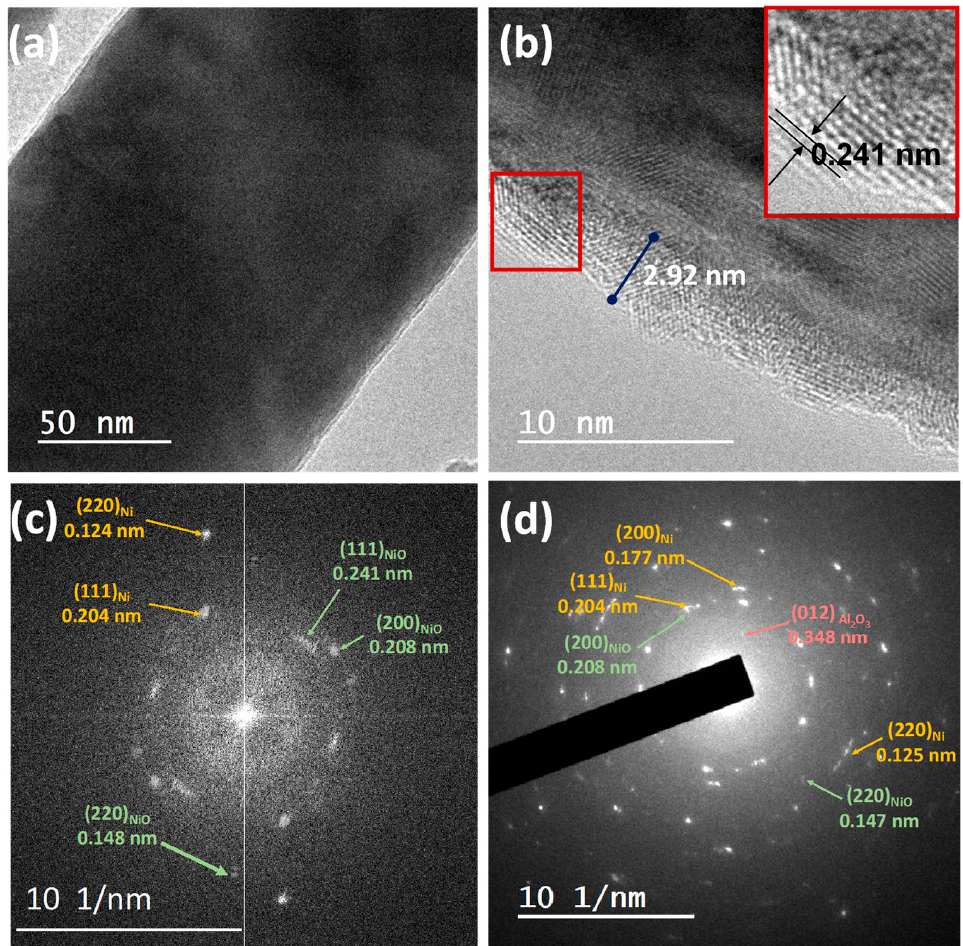
Figure 2. TEM and SAED studies of untreated Ni nanowires: ( a ) High-Magnification TEM image. ( b ) High-Resolution TEM image. The inset image is a magnification of the most external part of the nanowire where lattice fringes associated with the {111} planes of NiO are observed. ( c ) FFT of the micrograph of panel ( b ). ( d ) SAED pa tt ern of the same nanowire.